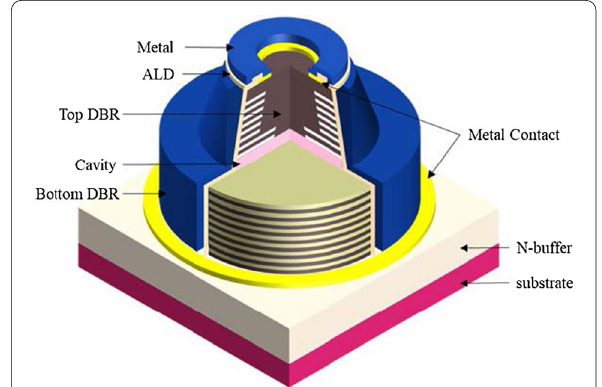
Fig. 6 Schematic of the VCSEL [42]